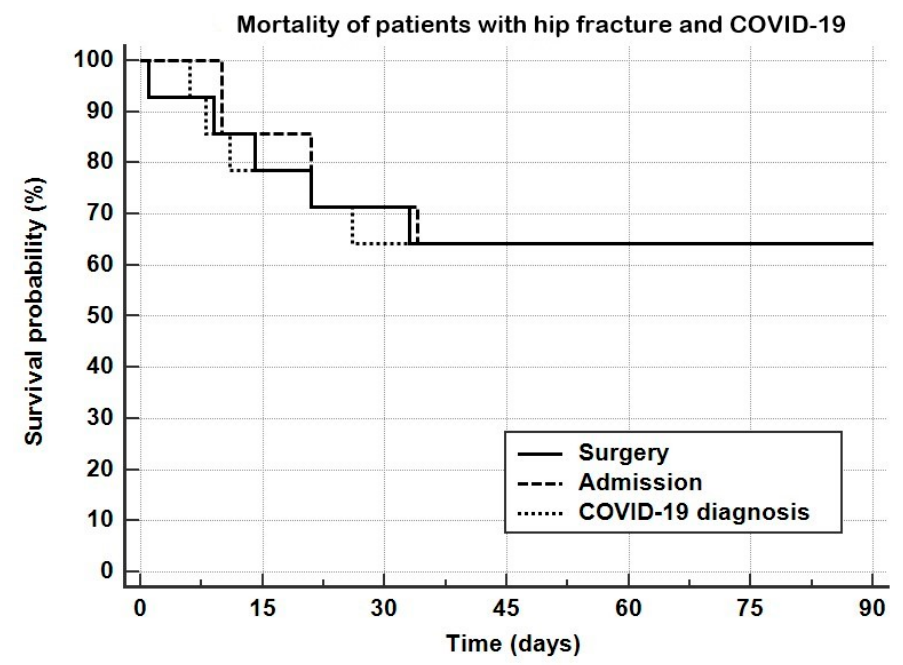
Figure 1. Ninety-day survival of COVID-19 patients calculated for time from surgery, time from hospital admission, and time from COVID-19 diagnosis.